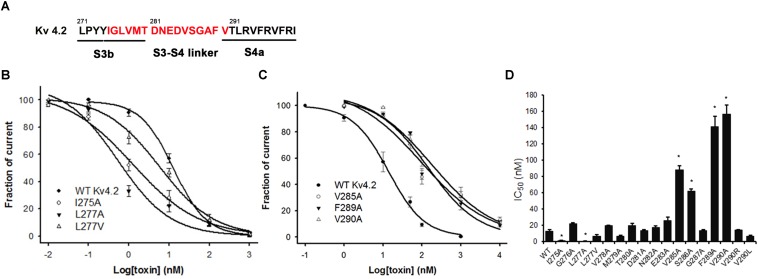
Inhibition effects of site mutants in the S3b and S3–S4 linker of Kv4.2 by JZTX-V. (A) S3b–S4 regions of Kv4.2. Red amino acids are those used in alanine-scanning mutagenesis site mutants on the S3b and S3–S4 linker. (B) Concentration-response curves for JZTX-V acted on WT-Kv4.2 and the mutants I275A, L277A, and L277V significantly increase affinity to JZTX-V. (C) Hydrophobic residues mutants V285A, F289A, and V290A lose affinity to JZTX-V. (D) IC50 values on S3–S4 linker of Kv4.2 channel mutants of JZTX-V. *P < 0.05 compared with WT group.